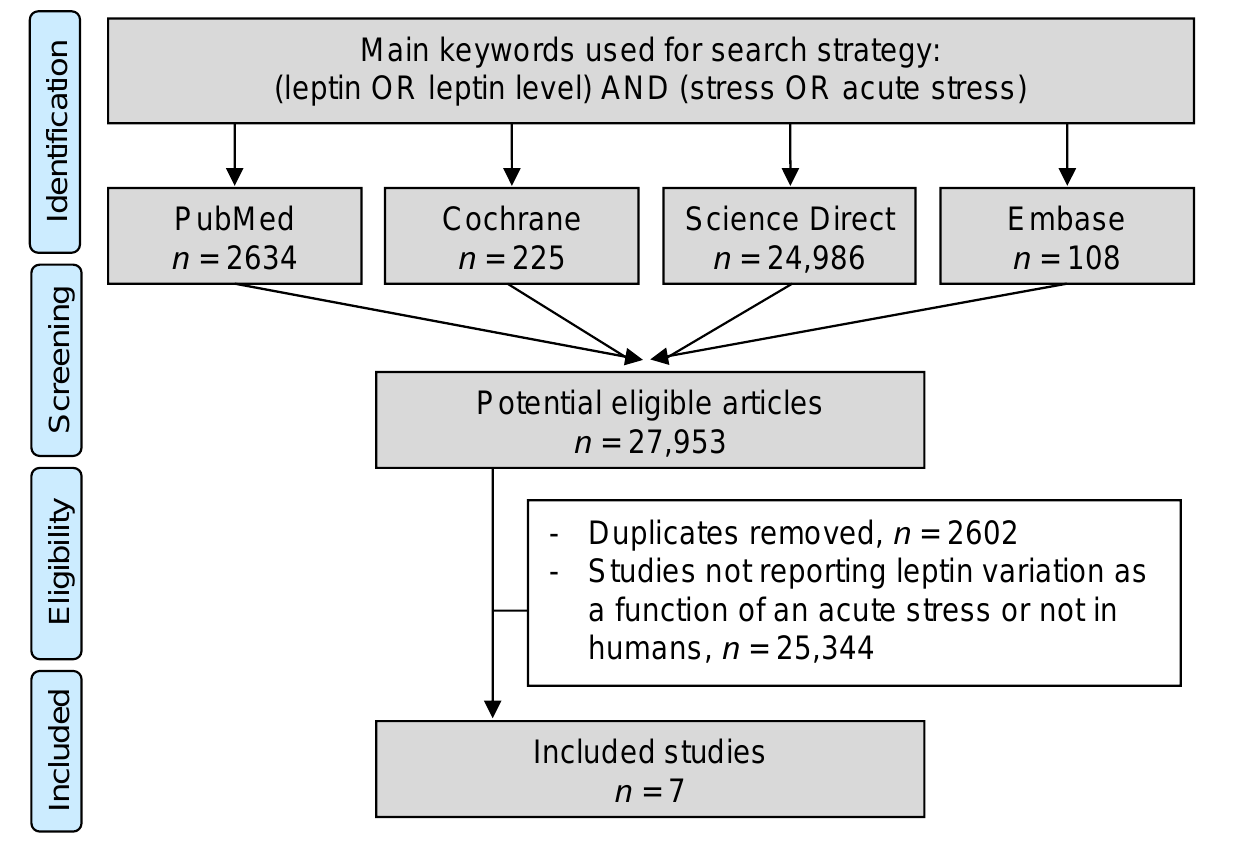
Figure 1. Search